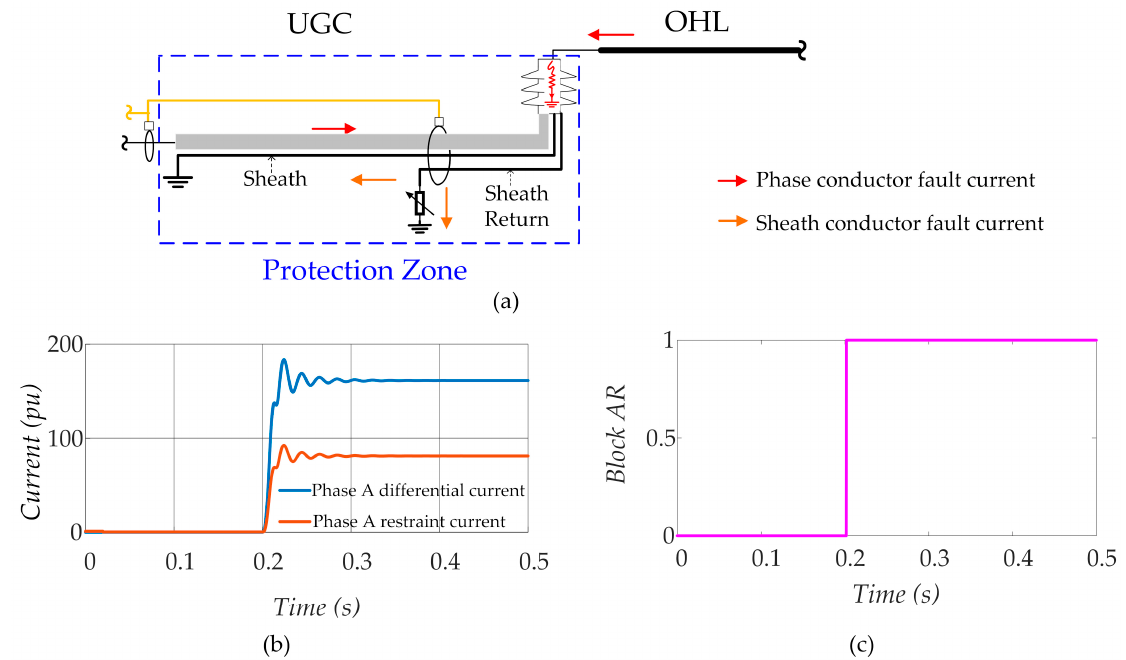
Figure 9. Performance of the proposed scheme for cable bushing faults; ( a ) protection zone of the proposed scheme, ( b ) differential and restraint currents due to cable busing fault, ( c ) output of the proposed scheme.